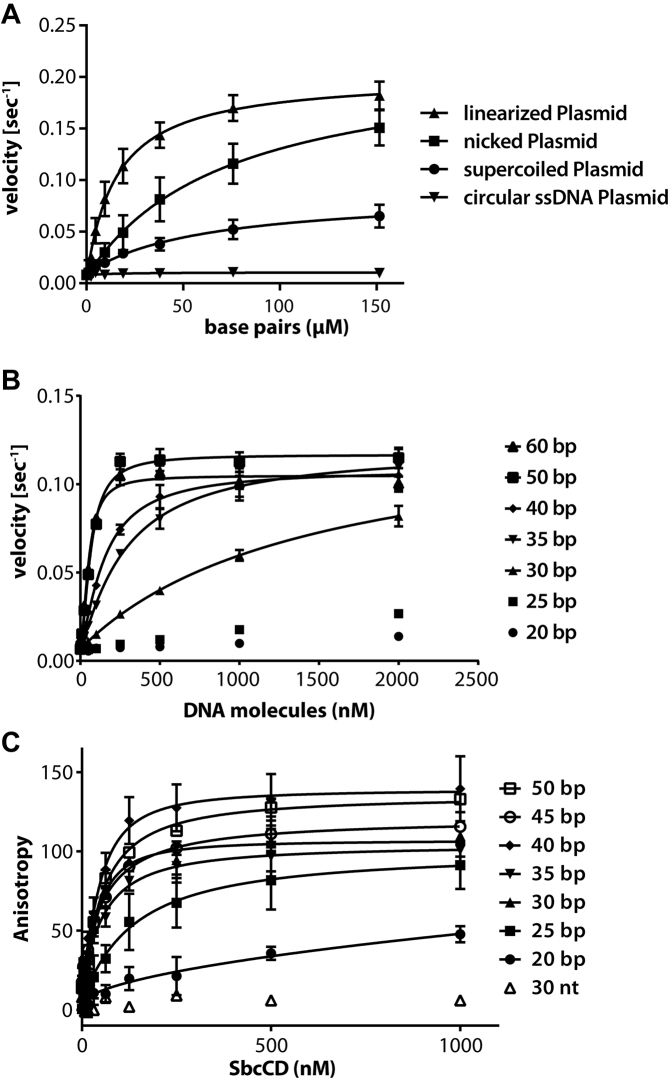
ATP hydrolysis stimulation and DNA binding of the SbcCDwt complex. (A) The ATP hydrolysis rate of SbcCDwt was measured in dependence to increasing plasmid DNA concentrations. Bacteriophage ΦX174 Plasmid DNA (5386 bp in length) was added as single-stranded, supercoiled, nicked or linear DNA. The data were fit to a Michaelis–Menten equation, error bars indicate the deviation from three replicates. (B) DNA stimulation of ATP hydrolysis by the nuclease-deficient SbcCDH84Q complex. The steady-state ATPase rates were measured at 37°C in the presence of 1 mM ATP, 5 mM MgCl2 and 1 mM MnCl2. DNA with 20–60 bp in length was added as an activator. The data was fit to a Michaelis-Menten equation, error bars represent the standard deviation of three measurements. (C) DNA binding of SbcCDH84Q to 20–50 bp DNA was assayed in the presence of 1 mM ATP, 5 mM MgCl2 and 1 mM MnCl2. DNA concentration was kept at 5 nM; the SbcCDH84Q concentration ranged from 2 to 1000 nM. Data points represent the change in fluorescence anisotropy and the data were fit to a 1 to 1 binding equation. Error bars represent the deviation from three independent experiments.